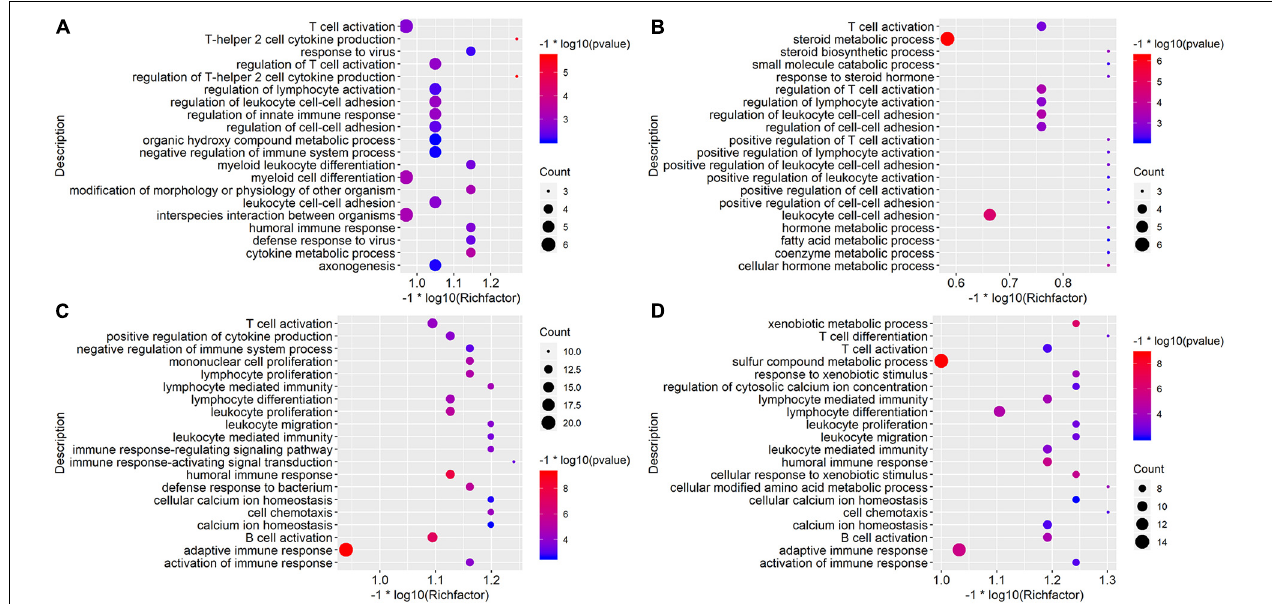
FIGURE 2 | Gene Ontology (GO) enrichment analysis of up-regulated DEGs in comparison groups. The top 20 significant Biological Processes terms of up-regulated DEGs in D10NTC vs. D10TOA group (A) , top 20 significant Biological Processes terms of up-regulated DEGs in D20NTC vs. D20TOA group (B) , top 20 significant Biological Processes terms of up-regulated DEGs in D30NTC vs. D30TOA group (C) , and top 20 significant Biological Processes terms of up-regulated DEGs in D30NTC vs. D35TOA group (D) . Size and color of the bubbles are measured as count and p- value to represent the amount of DEGs enriched in these terms and the enrichment significance.